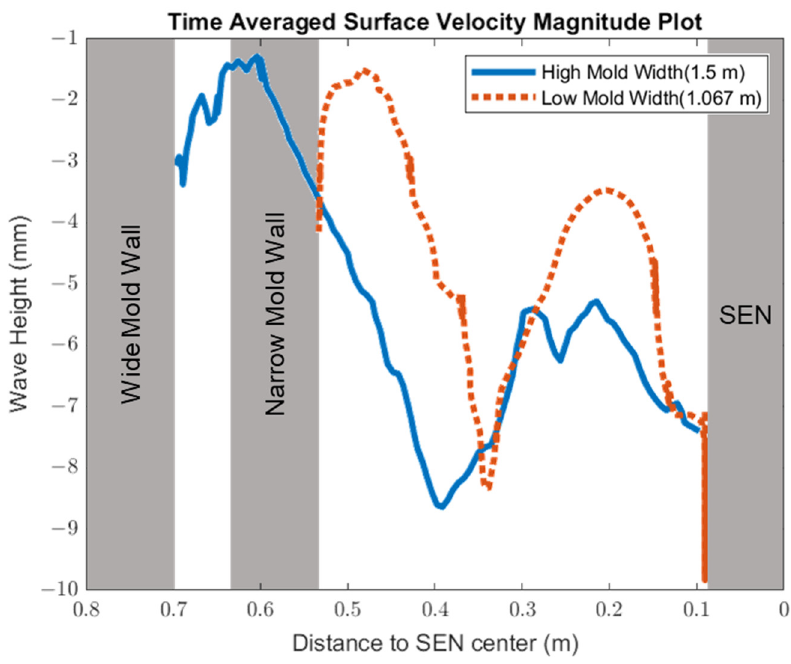
Figure 19. Low mold width (Case 5) vs. high mold width (Case 7) standing wave comparison.